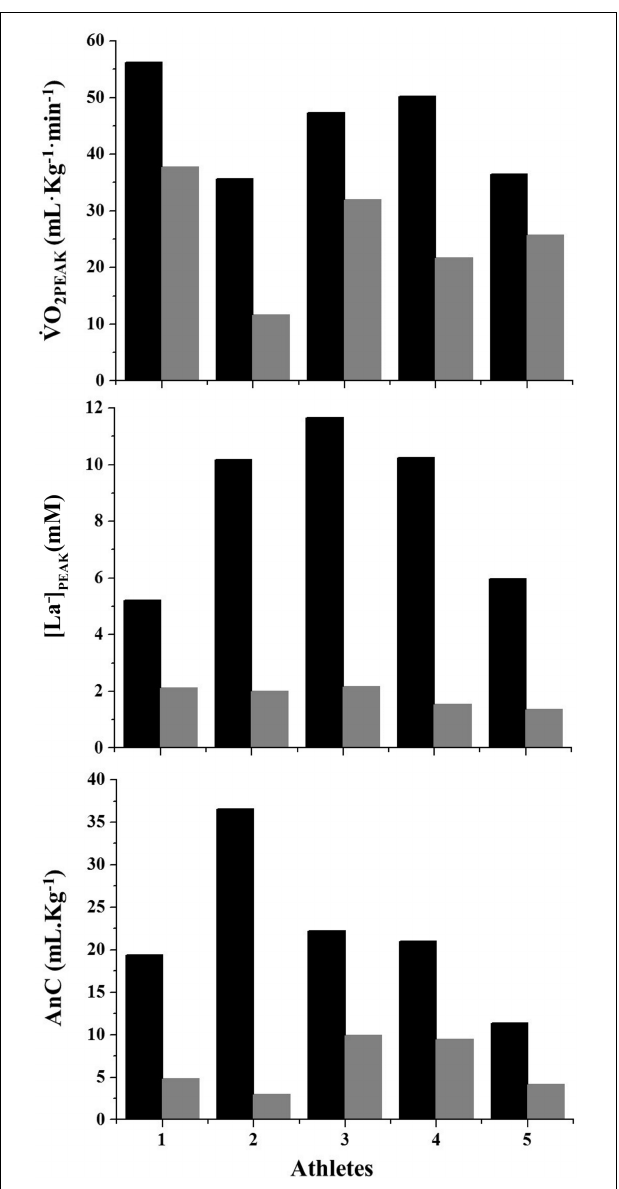
FIGURE 1 | Individual values of peak oxygen consumption (˙VO 2PEAK ), peak blood lactate concentrations ([La − ]) PEAK , and anaerobic contributions (AnC), observed in the laboratory condition (black bars) and during simulated games (gray